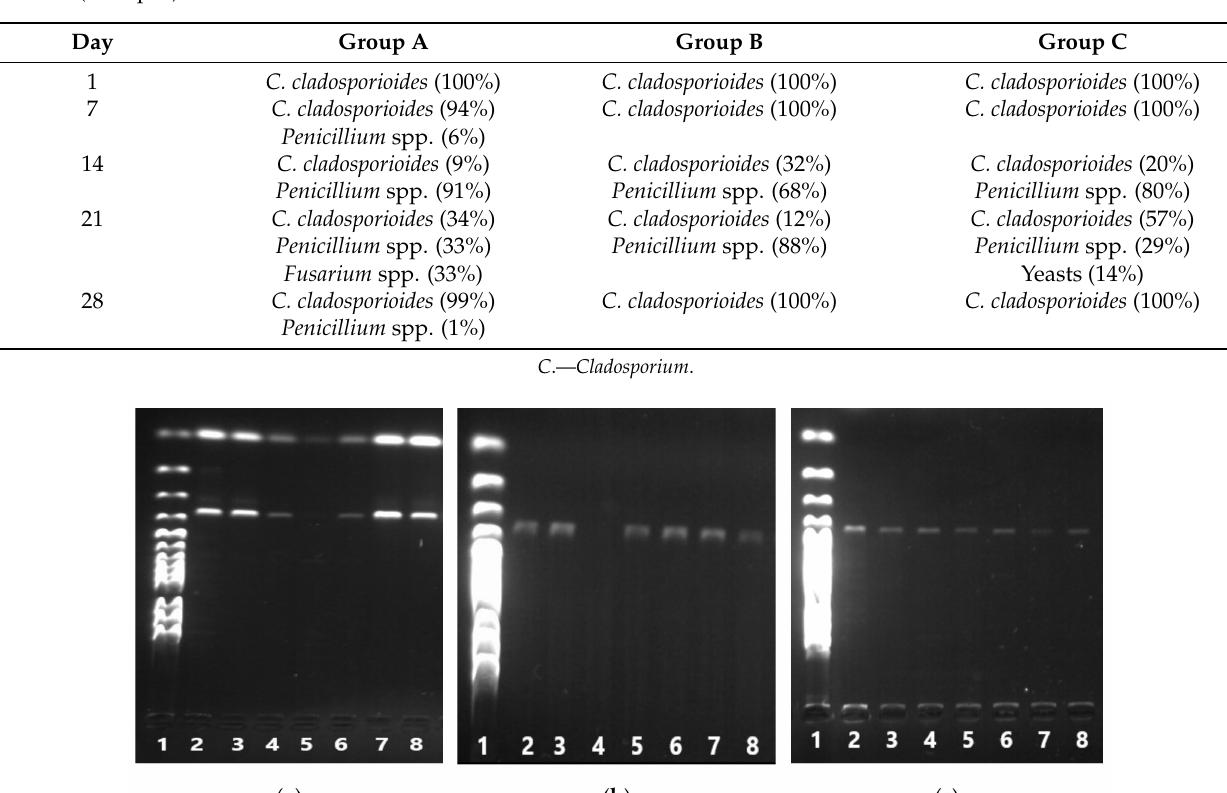
Table 3. Proportion of mold genera on the eggshell of experimental eggs stored at 11 ◦ C (Group A), 3 ◦ C (Group B) and 20 ◦ C (Group C).